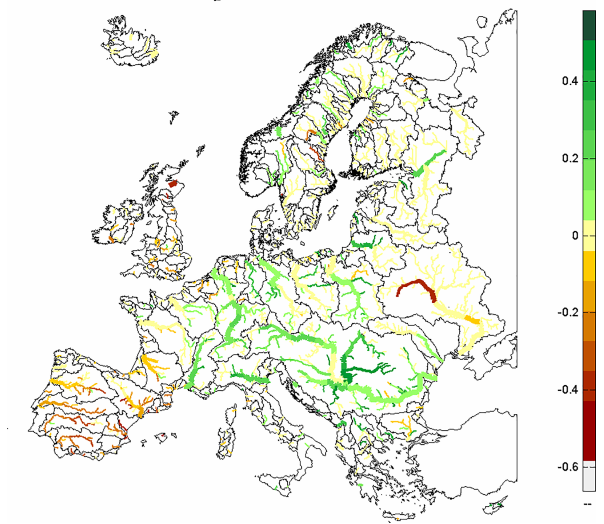
Figure 3. Relative changes of water availability in the long term period (2060–2099) with respect to the control period (1960–1999) under emission scenario RCP4.5 according to PCR-GLOBWB model forced with GFDL climate